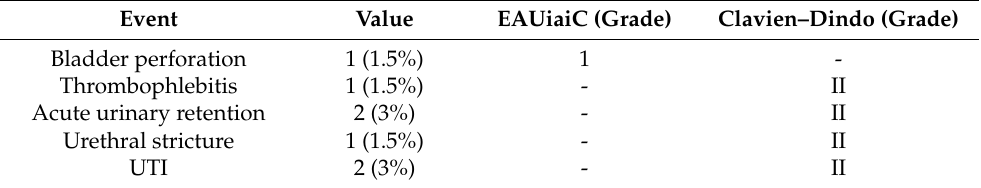
Table 3. Intra- and postoperative